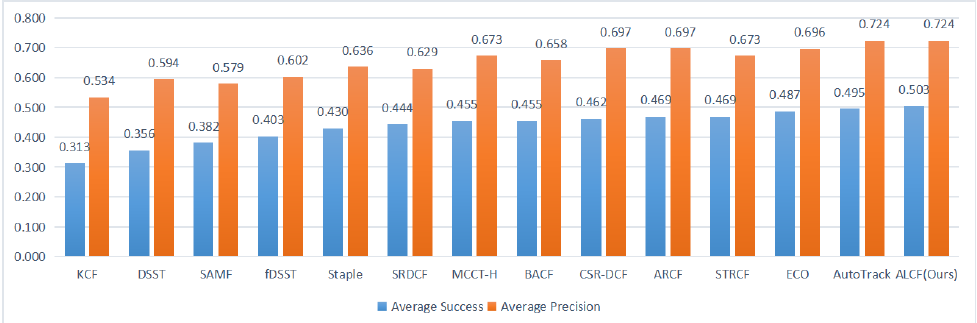
Figure 9. Overall evaluation of ALCF and other trackers regarding average precision and success